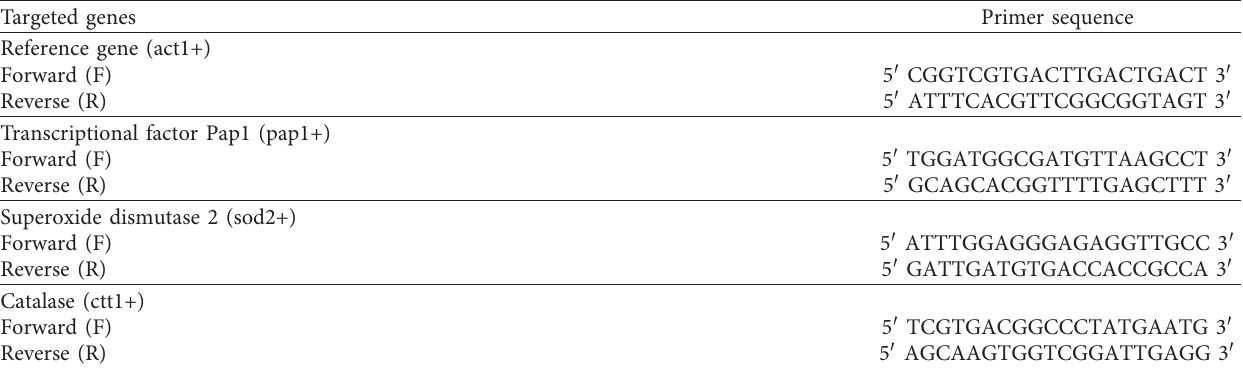
Table 2: Primer pairs used in the analysis of gene expression by using